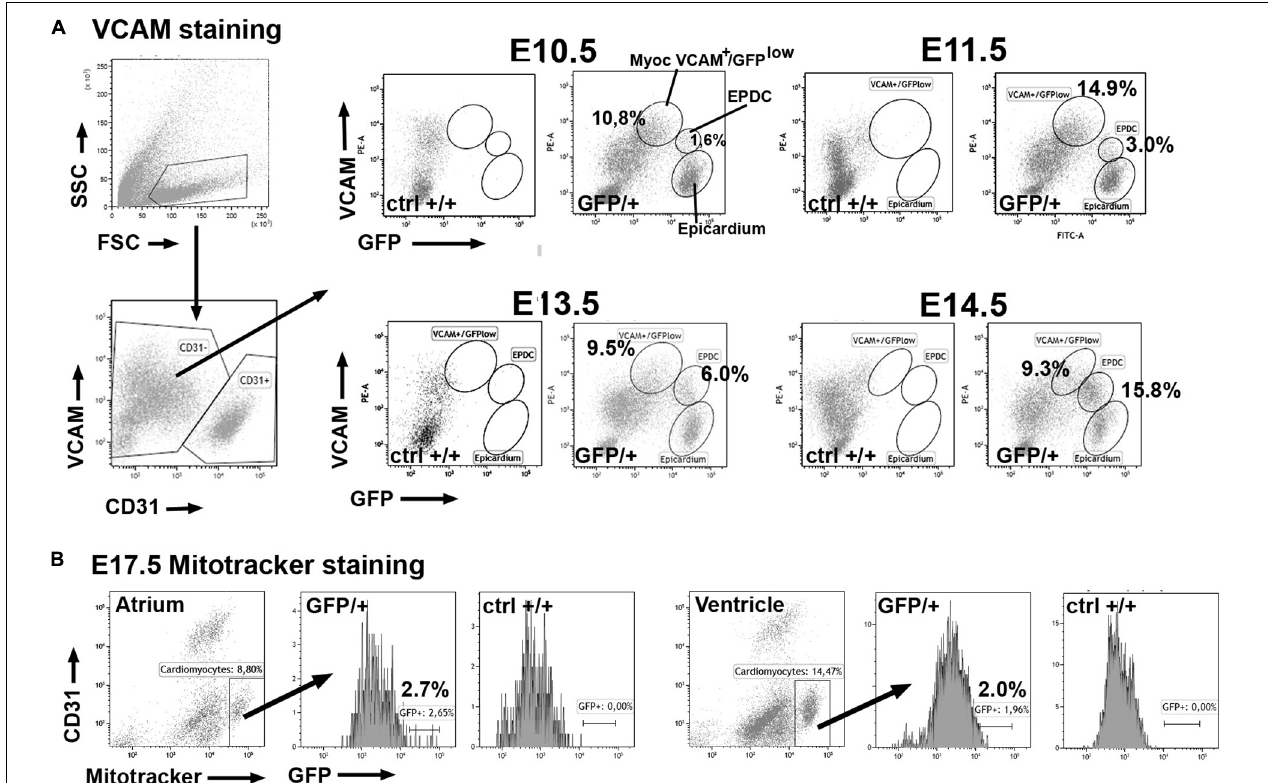
FIGURE 1 | Expression of the GFP reporter in cardiomyocytes of the WT1 GFP / + knockin line (GFP/ + = heterozygous embryos; ctrl + / + = homozygous negative controls). Representative cytograms obtained from the analysis of 29 embryos. (A) Cardiomyocytes can be identified as VCAM+ /CD31- cells in the earliest stages of cardiac development. A fraction of these cardiomyocytes expresses the GFP reporter (top row) at lower levels than epicardial cells. In stages E13.5–E15.5 the reporter expression decreases in the VCAM + population. Note the increasing population of VCAM + expressing cells that represent the epicardial-derived